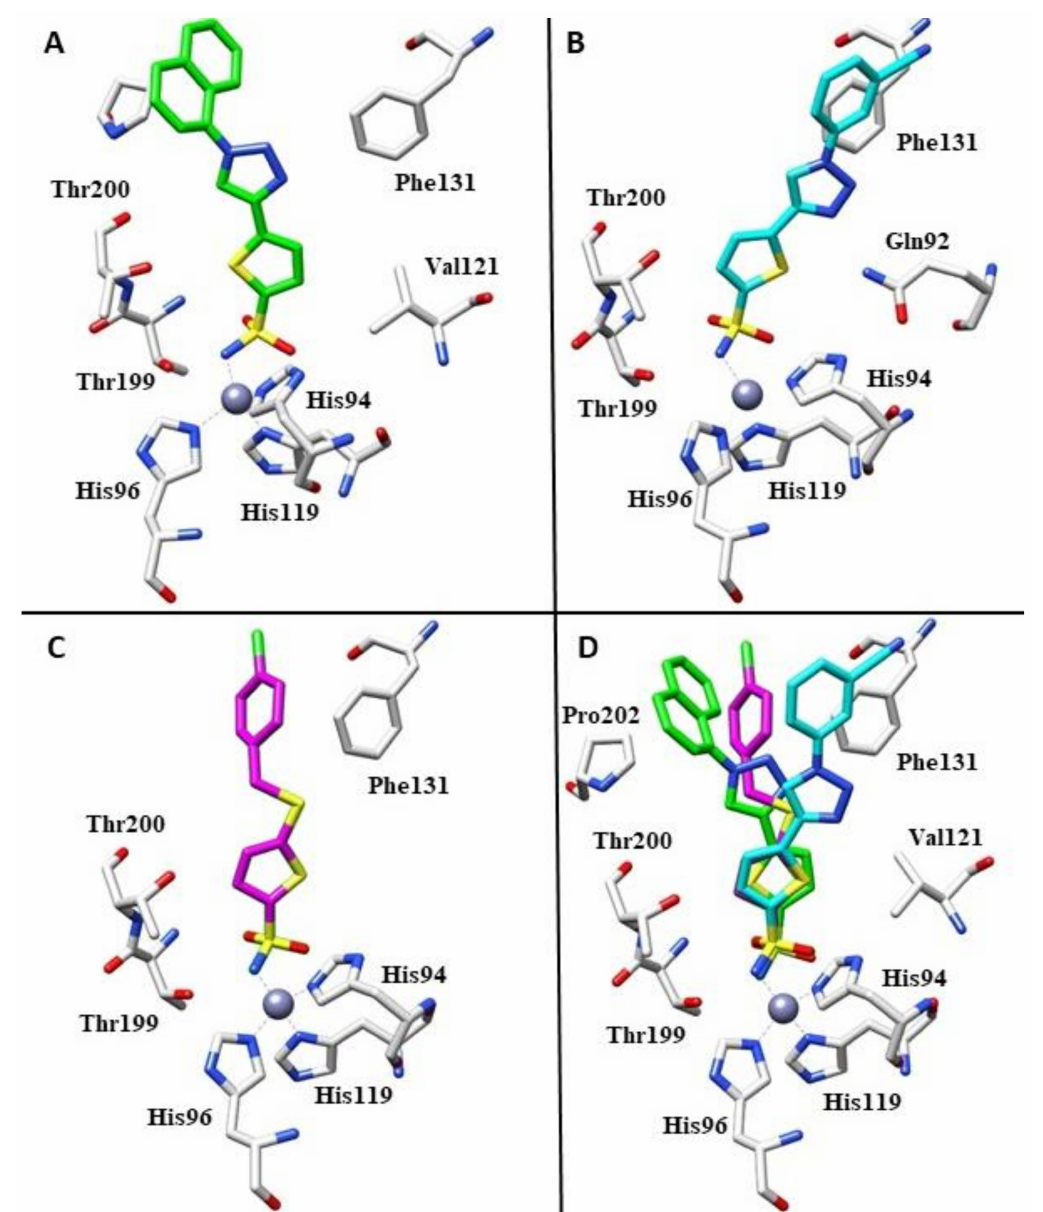
Figure 3. ( A ) Binding mode of compound 22f within the active site of hCA II (PDB: 4BF1). ( B ) Binding mode of compound 22i within the active site of hCA II (PDB: 4BF6). ( C ) Binding mode of compound 23l within the active site of hCA II (PDB: 5MJN). ( D ). Superimposition of compounds 22f , 22i and 23l in complex with hCA